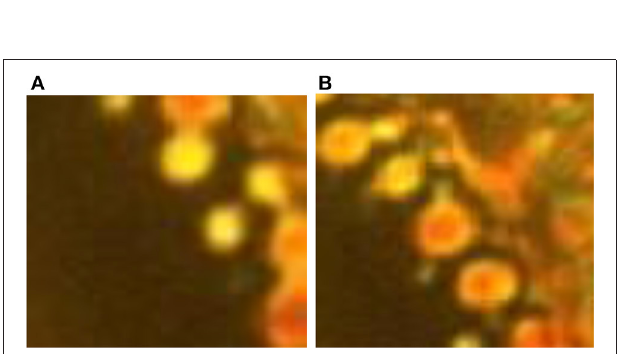
FIGURE 4 | Domains in the interfacial zone. The interfacial zone consists of (A) “small” ( D < 500nm) and (B) “big” ( D > 500nm) domains.